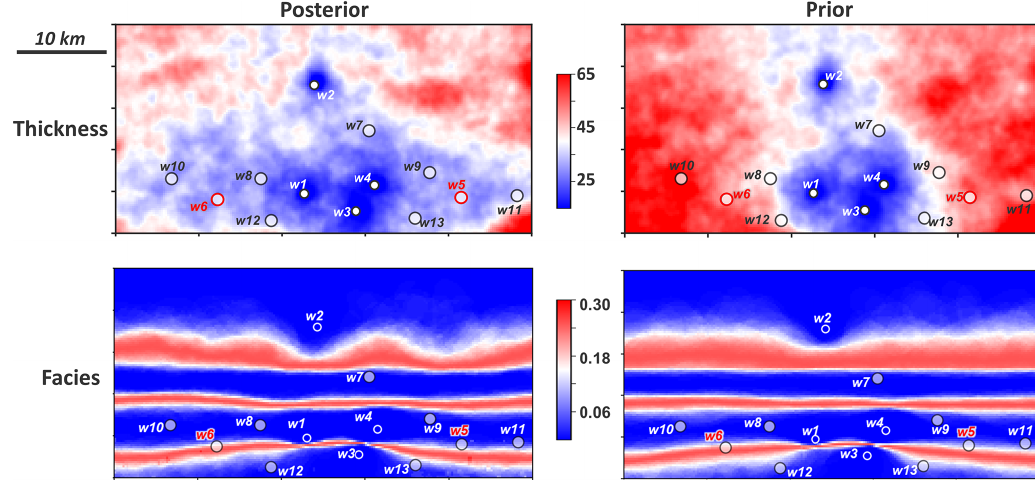
Figure 13. Ensemble variance of the posterior and prior thickness and facies models from the first